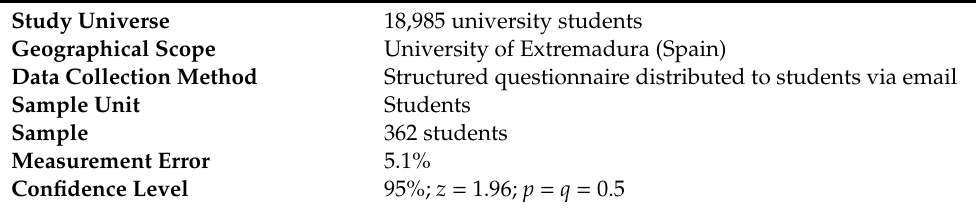
Table 1. Research Data